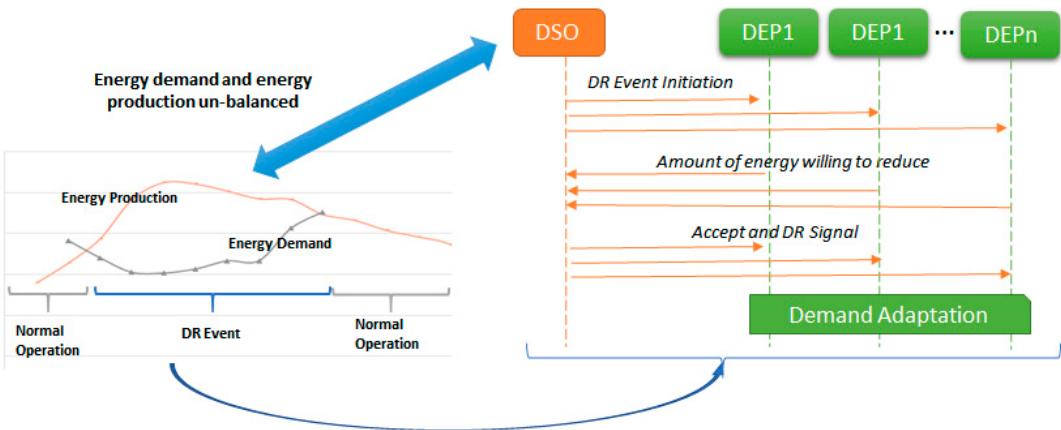
Figure 1. Centralized management of Demand Response (DR) programs in smart grids for energy demand management. DEP = Distributed Energy Prosumers.